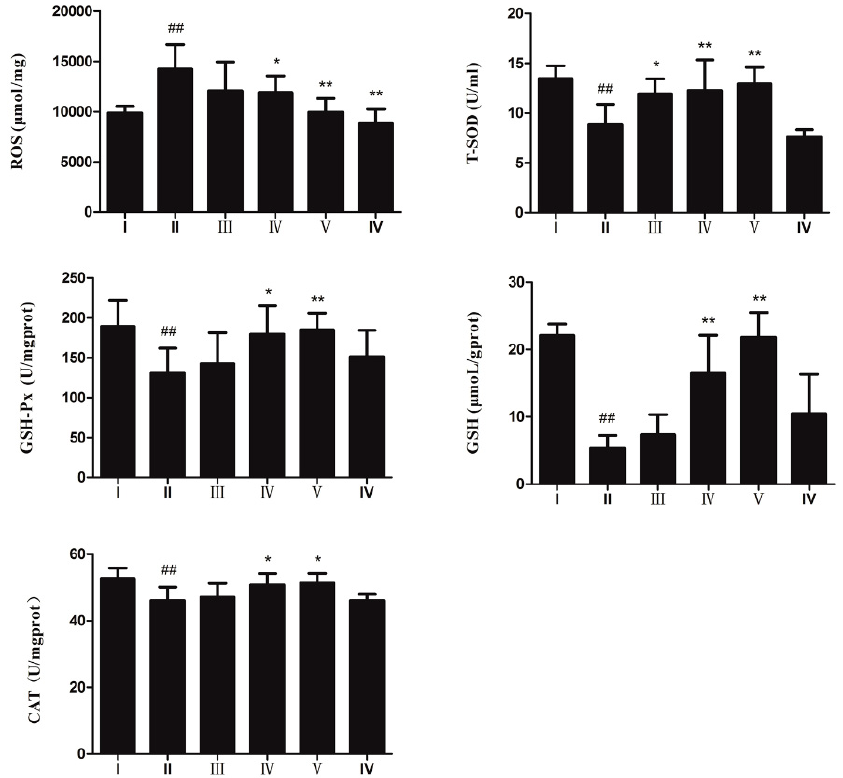
Figure 3. Levels of reactive oxygen species (ROS), superoxide dismutase (T-SOD), glutathione (GSH), glutathione peroxidase (GSH-Px), and catalase (CAT) in liver tissues. Groups are as follows. I: saline; II: saline + CCl 4 ; III: AEOV 125 mg/kg + CCl 4 ; IV: AEOV 250 mg/kg + CCl 4 ; V: AEOV 500 mg/kg + CCl 4 ; VI: biphenyldicarboxylate 150 mg/kg + CCl 4 . Values are the means ± SEM of three independent experiments. ## p < 0.01 versus normal control group, ** p < 0.01, * p < 0.05 versus CCl 4 -treated group.